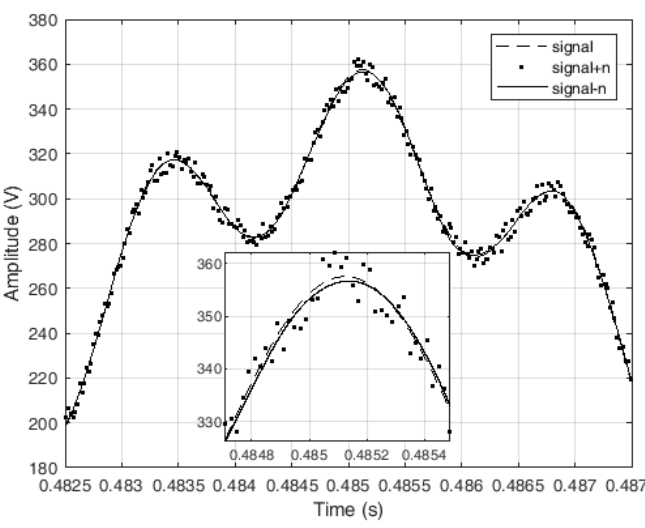
Figure 9. Detail of denoising signal with interharmonics.